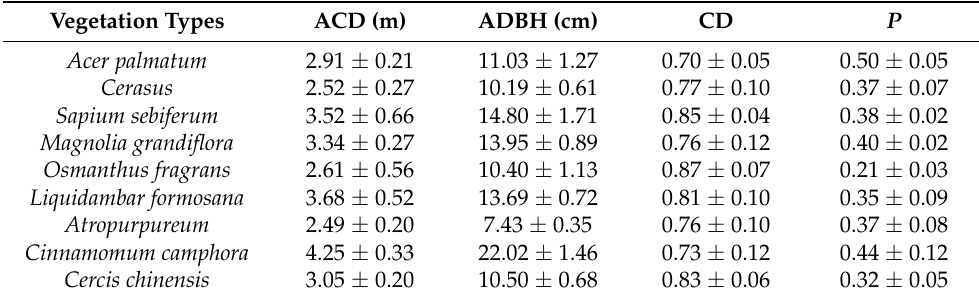
Table 1. Survey of different vegetation types of trial site. Vegetation